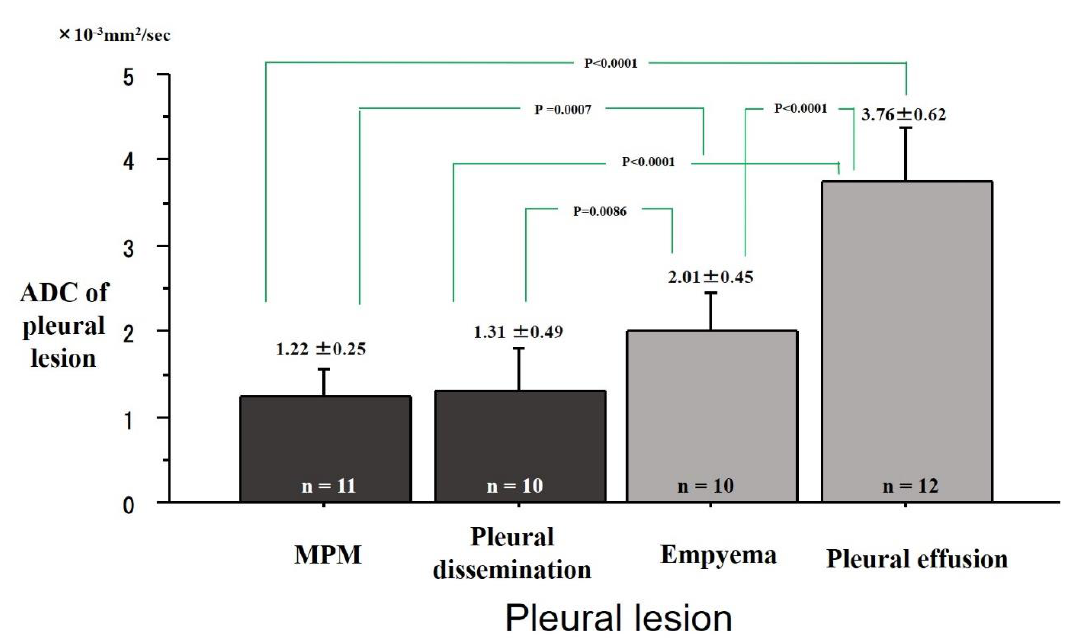
Figure 5. Differences of apparent diffusion coefficient (ADC) of pleural lesions. Mean ADCs were